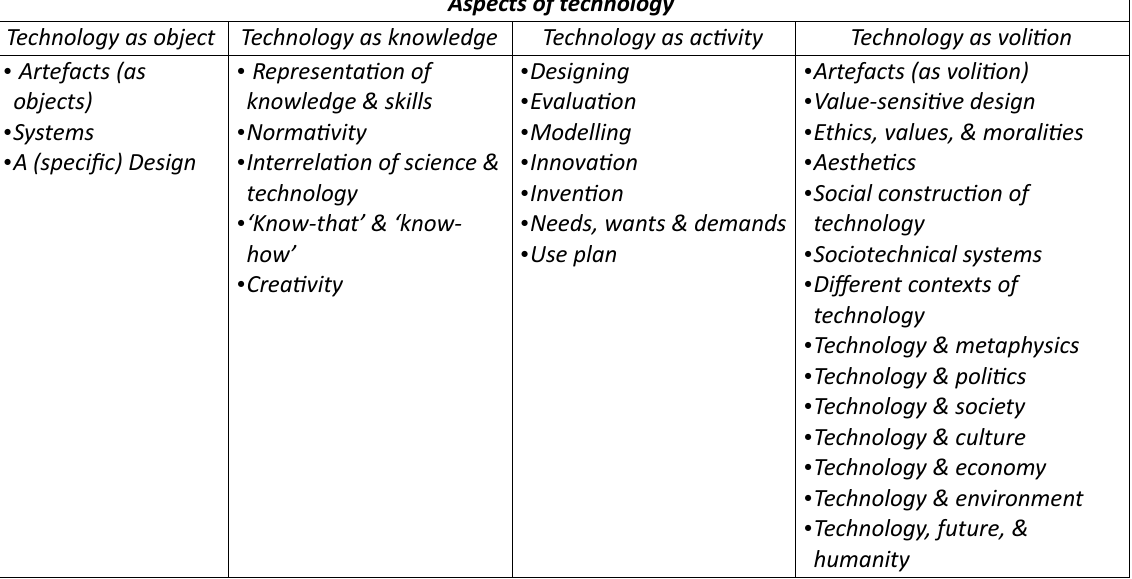
Table 1. The Main Framework of the Paper: concepts of technology from different aspectual